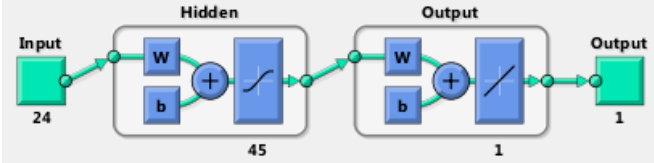
Figure 7. The architecture of the feedforward neural network.